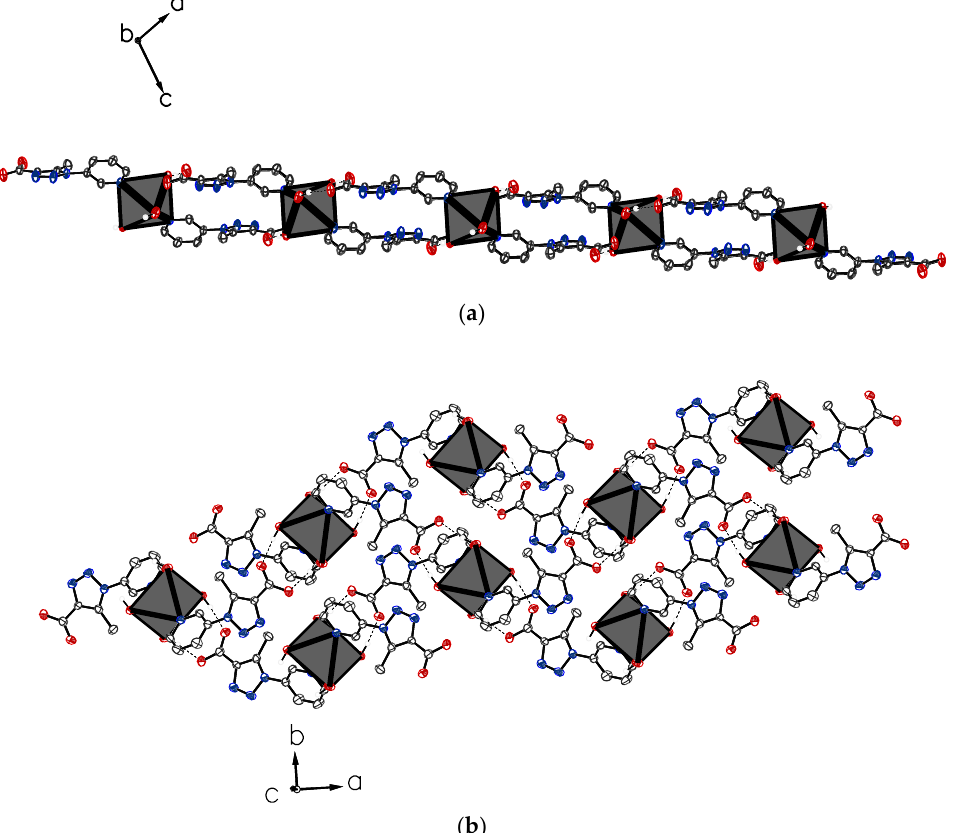
Figure 4. Slabs generated along the (101) plane ( a ) and the (110) plane ( b ), showing the coordination polyhedral.